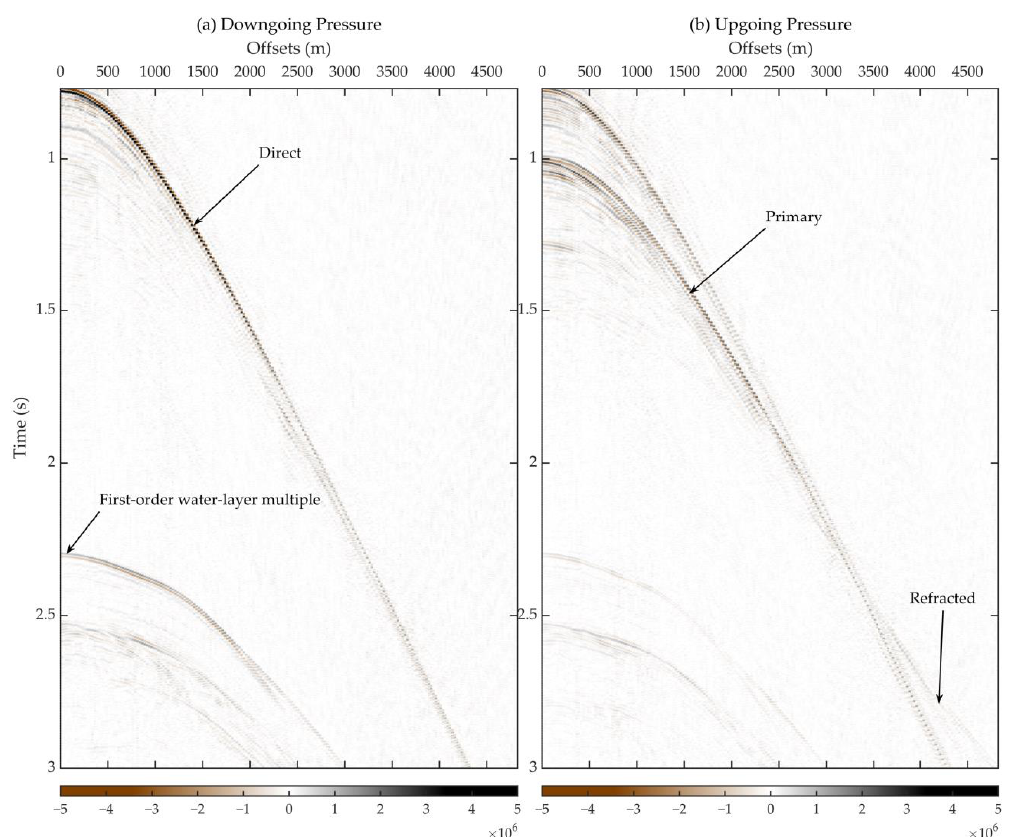
Figure 8. The ( a ) downgoing and ( b ) upgoing acoustic pressure separated just above the seafloor in the t-x domain. The colormaps have been unified. The direct wave and the first-order water-layer multiple in downgoing pressure and critically refracted and primary reflected waves in upgoing pressure are indicated by the black arrows.